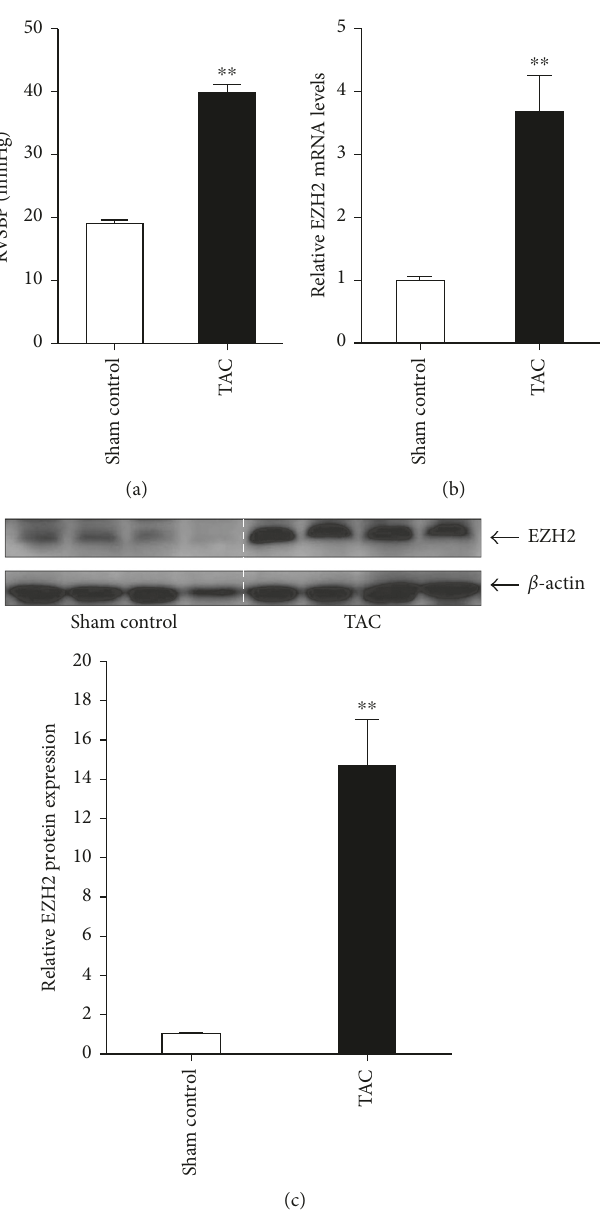
Figure 1: Expression of EZH2 is upregulated in lungs in TAC-induced PAH mice. (a) Right ventricular systolic blood pressure (RVSBP) at day 28 after TAC procedure ( n � 4 for each group, ∗∗ P < 0 . 001 versus sham control). Relative mRNA (b) and protein (c) levels of EZH2 in lungs in sham control mice or TAC mice on day 28 following TAC procedure ( n � 4 for each group, ∗∗ P < 0 . 001 versus sham